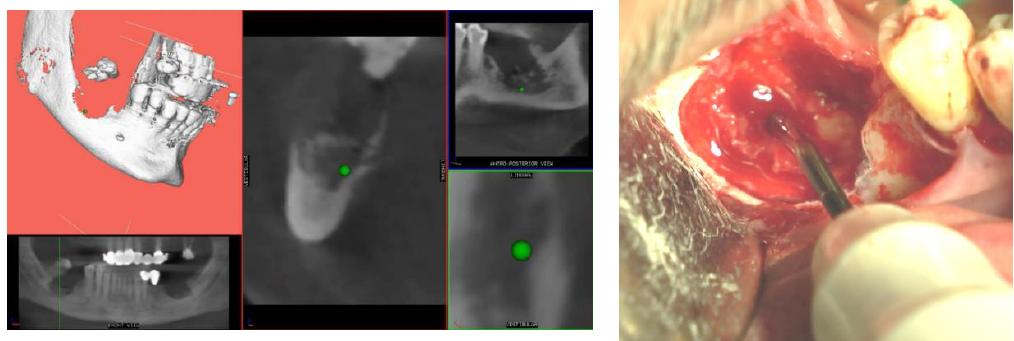
Figure 4. The navigated piezoelectric bone curettage on the right side.